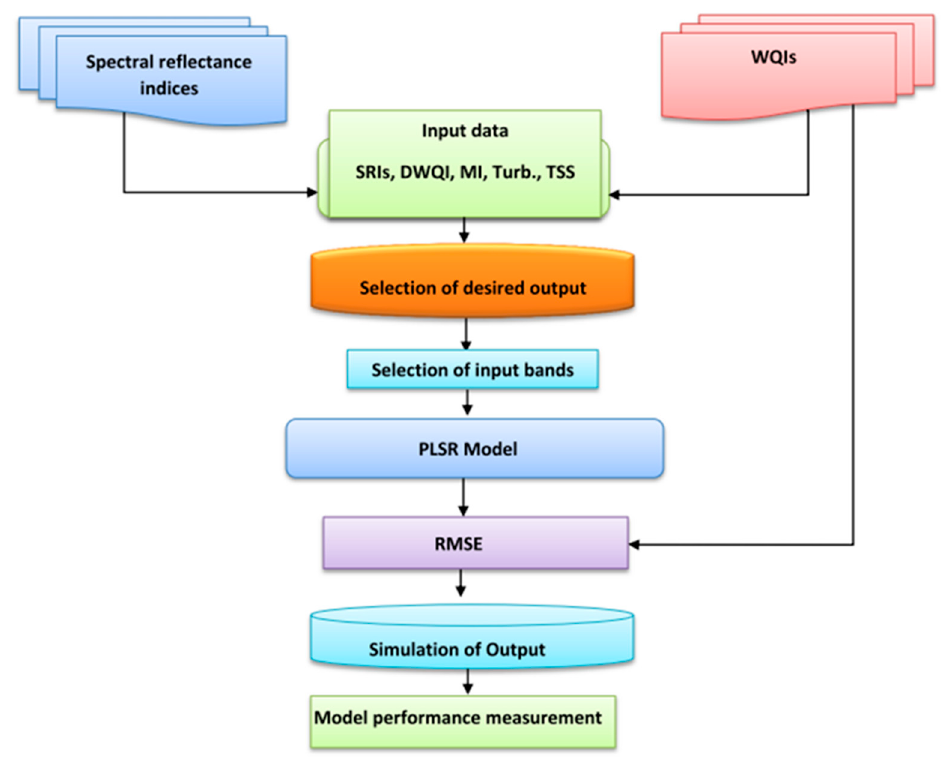
Figure 2. Flowchart diagram of the methodology for estimating water quality indices (WQIs) using PLSR model.